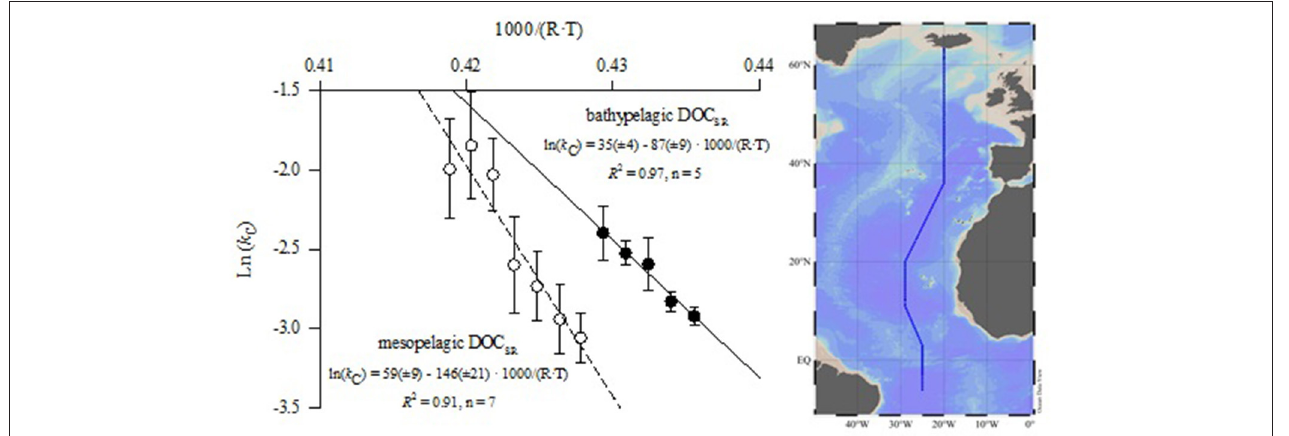
FIGURE 1 | Arrhenius plots of the ln of DOC decay constants (ln k C ) against the inverse absolute temperature (1/T) for the meso- and bathypelagic North Atlantic Ocean along the CLIVAR A16N line (Map of cruise track is shown to the right). Solid and dashed lines represent the corresponding regression lines. Origin intercept and slope of the regression equations and their corresponding standard errors of estimation are provided; R 2 , coefficient of determination; error bars represent standard errors. The map was createdusing Ocean Data View (Schlitzer, 2016).